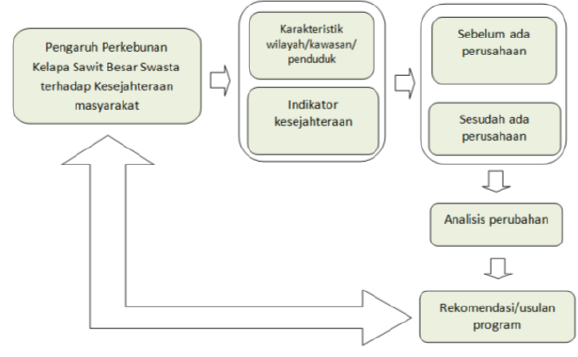
Figure 1: Original framework for thinking